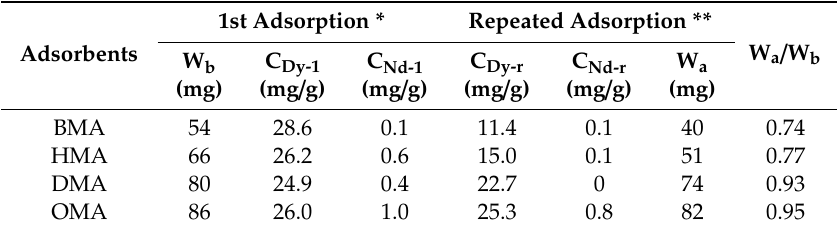
Table 3. Summary of the first and repeated batch adsorption